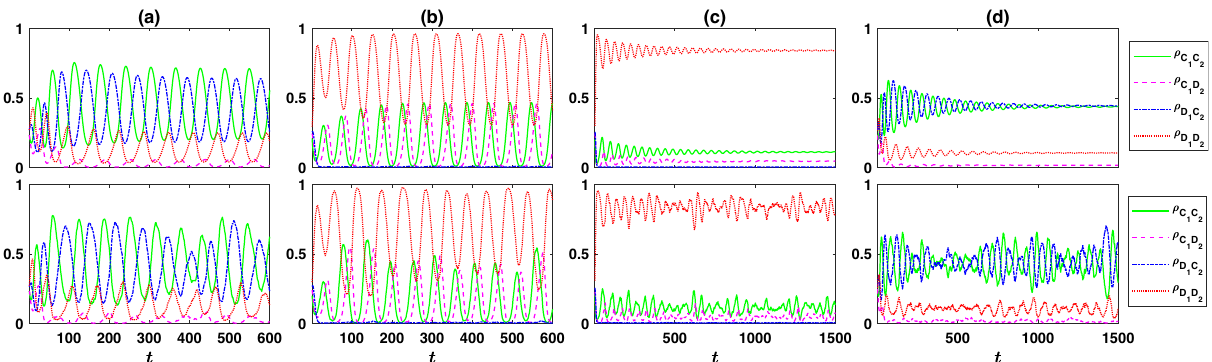
Figure 4. The time evolution of the system in assortative public goods games. ( a )–( d ) The frequency of different strategies as a function of time. Top panels show replicator dynamics solutions and the bottom panels result form the simulations in a population of N = 5000 individuals. The system shows two different periodic orbits. A cooperative periodic orbit, with higher level of cooperation for larger r 2 , r 2 = 4.8 in ( a ), and a defective periodic orbit, for small r 2 , r 2 = 2.4 in ( b ). In the fixed point of the dynamics for small r 2 but larger than 2 − r 1 / g , as in ( c ) where r 2 = 2 , only C 1 C 2 cooperators evolve, and for large r 2 , r 2 = 5.6 in ( d ), both C 1 C 2 and D 1 C 2 evolve. Here, g = 10 , ν = 10 − 3 , c = 1 , π 0 = 2 , and r 1 = 2.8 . The replicator dynamics is solved starting from homogeneous initial conditions and simulations are performed starting from random assignment of